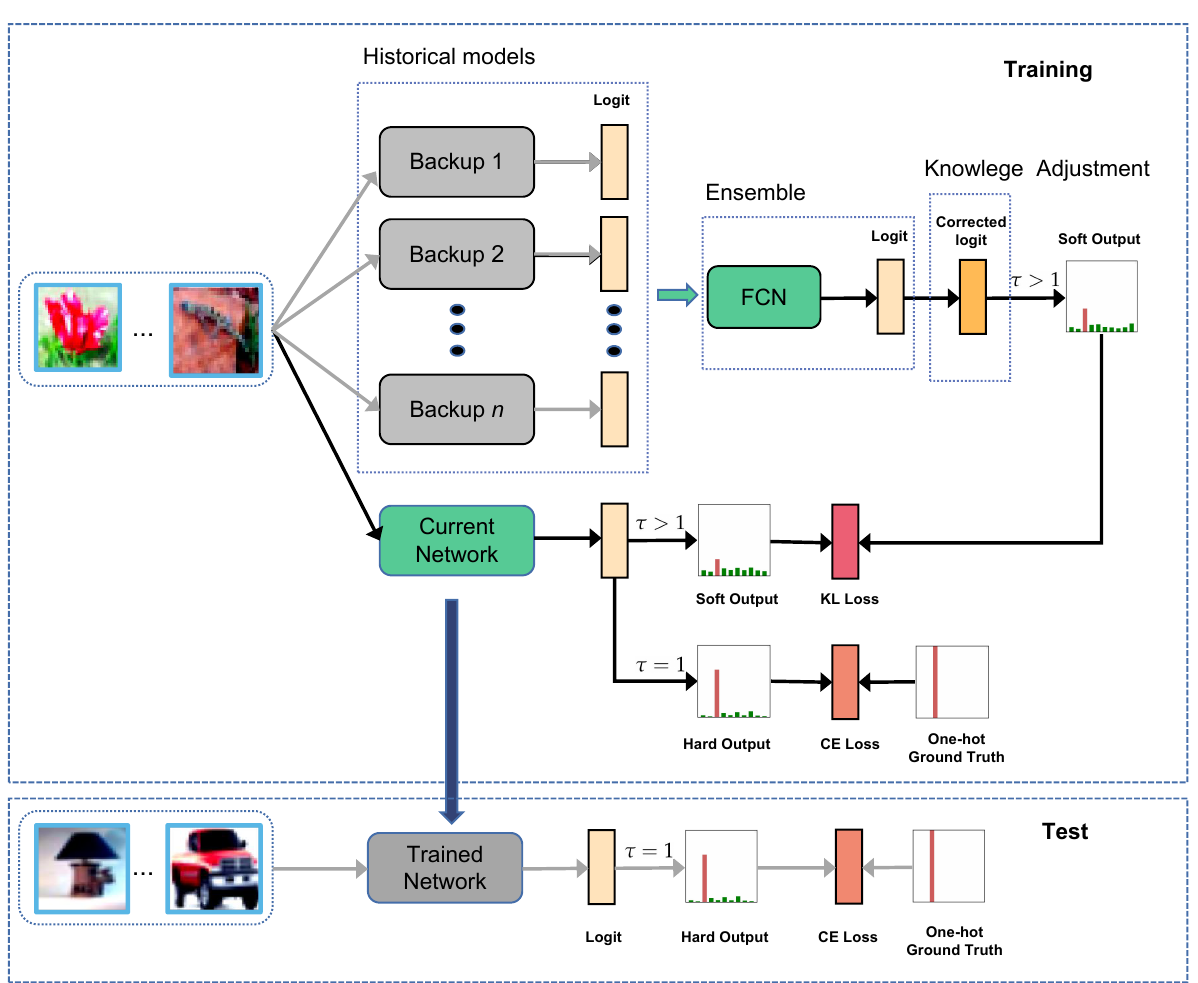
Figure 1. The framework of our proposed memory replay Knowledge Method with Fully Connected Network and Knowledge